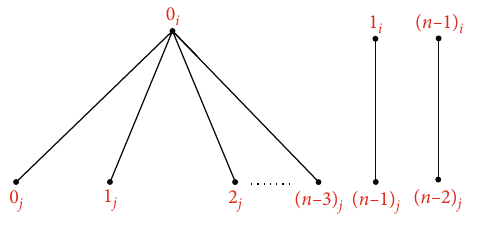
Figure 11: The labelling for ð nK